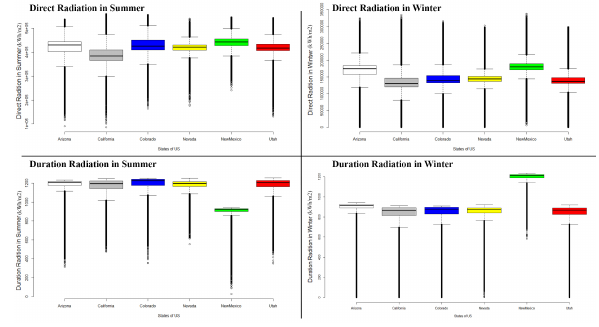
Figure 5. Boxplot for solar Radiation in summer and Winter.